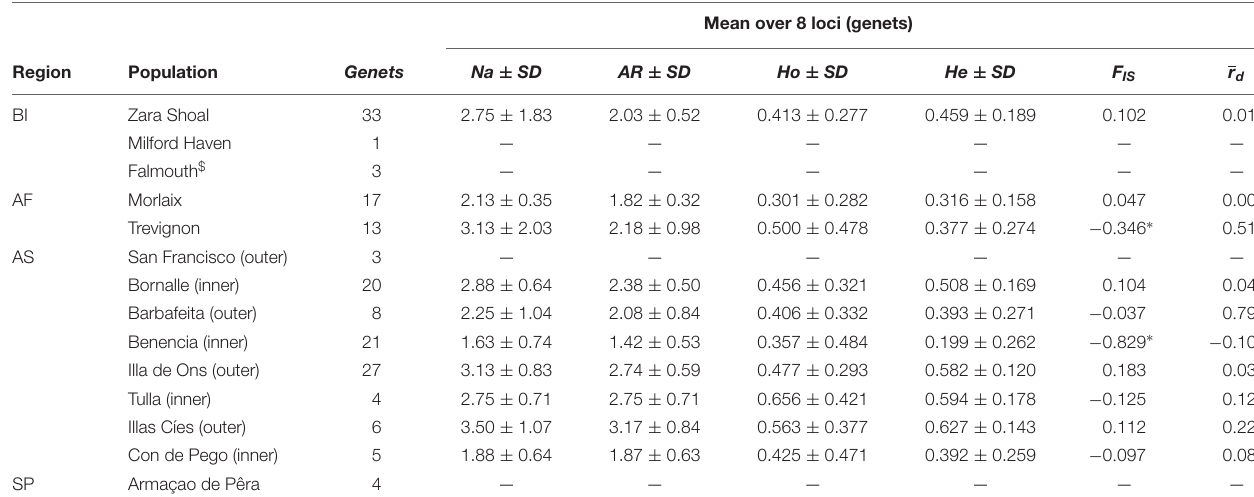
Mean over 8 loci